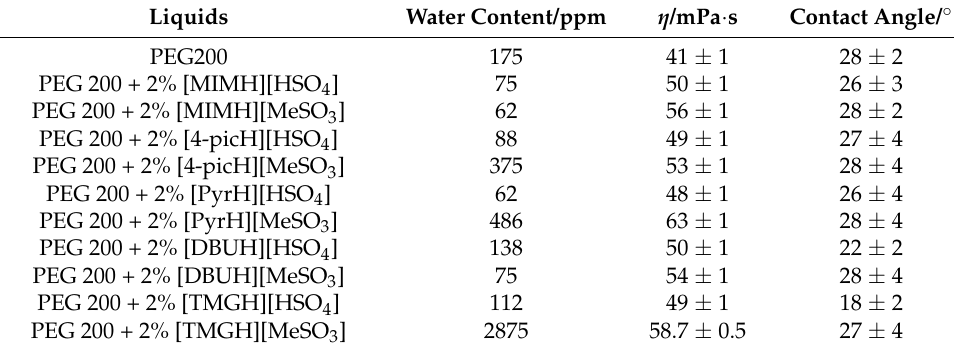
Table 1. Water content, viscosity, η , at 25 ◦ C and equilibrium contact angle on Si substrates of PEG200 and the mixtures. The standard deviations correspond to n = 3 for viscosity and n ≥ 4 for contact